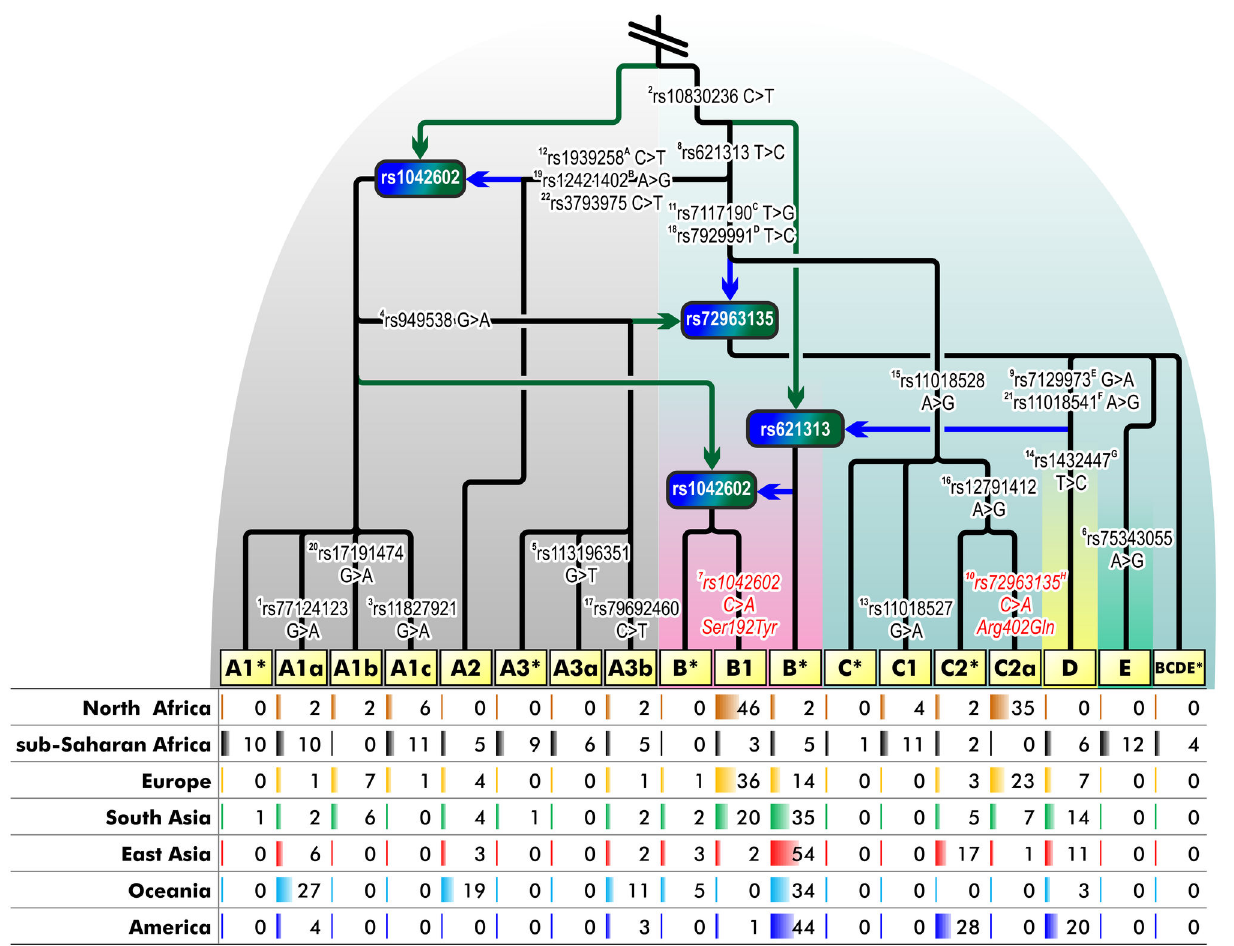
Figure 3. Ancestral recombination graph of TYR haplotypes. The tree is rooted by the chimpanzee sequence and presents recombination history of 942 worldwide samples (1884 chromosomes). Haplogroup frequency by populations is shown below the tree. Haplogroup names are shaded in yellow. Green arrows show the origin of recombination prefixes, blue arrows show the origin of recombination suffixes. Recombination points are shown by rectangles. Numerical superscript prefixes to the left of rs identifiers correspond to the relative physical position of SNPs. SNPs which were out of the range of our re-sequencing alignment are marked with superscript suffixes to the right of respective rs identifiers and correspond to the following phylogenetic equivalents in our re- sequencing data: A – rs12799137, B – rs7108676, C – rs12799347, D – rs12417632, E and F – rs5021654, G – rs7934747, H – rs1126809. Non-synonymous mutations or their phylogenetic equivalents are shown in red font with amino-acid substitutions specified. 95% confidence intervals for the detected haplogroup frequencies are given in Table S6. doi: